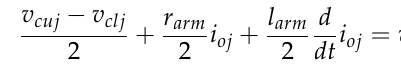
Figure 2. Single-phase equivalent circuit of MMC. Subtracting (3) from (2), and applying (1), one may